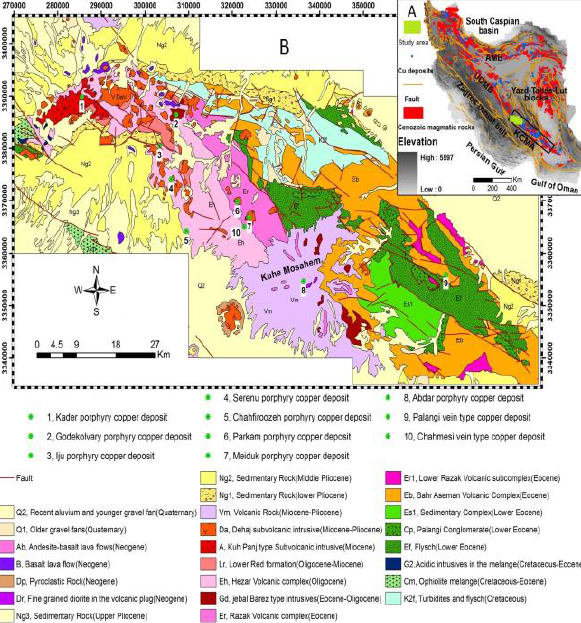
Figure 1. map A shows location of Shahr-e-Babak area in the Urumieh–Dokhtar magmatic arc. Map B shows location of important ore deposits and lithological unites of study